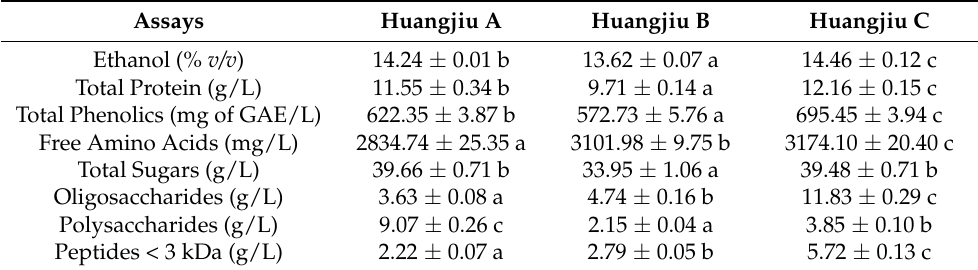
Table 1. Main components in three types of Huangjiu.